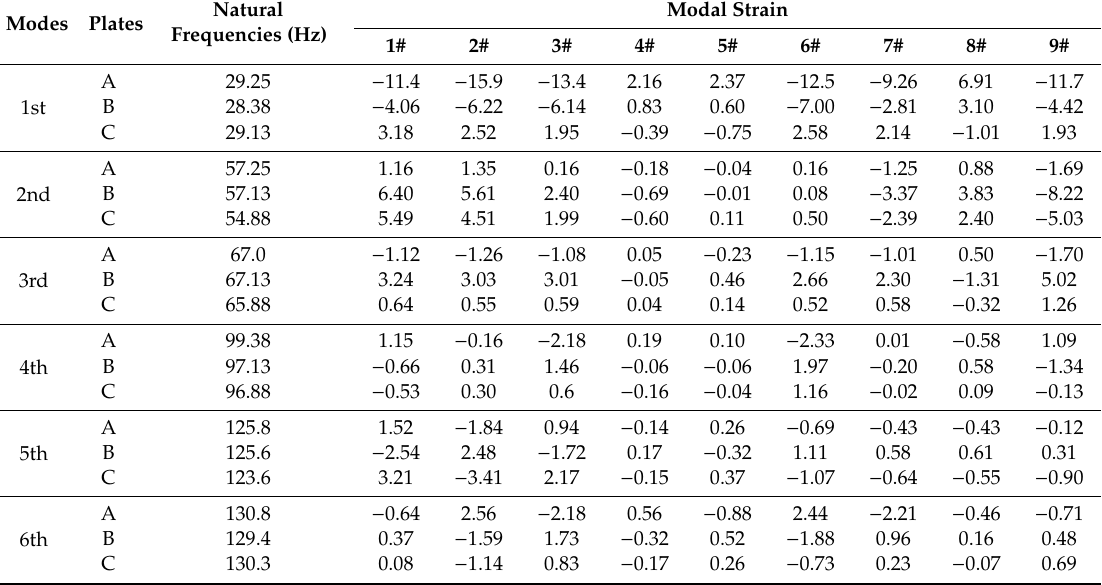
Table 3. Strain modal parameters of intact and damaged